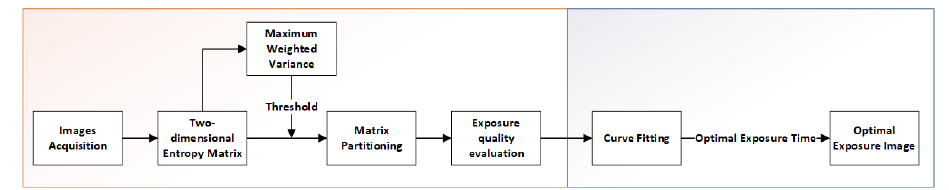
Figure 2. Overall architecture of the proposed